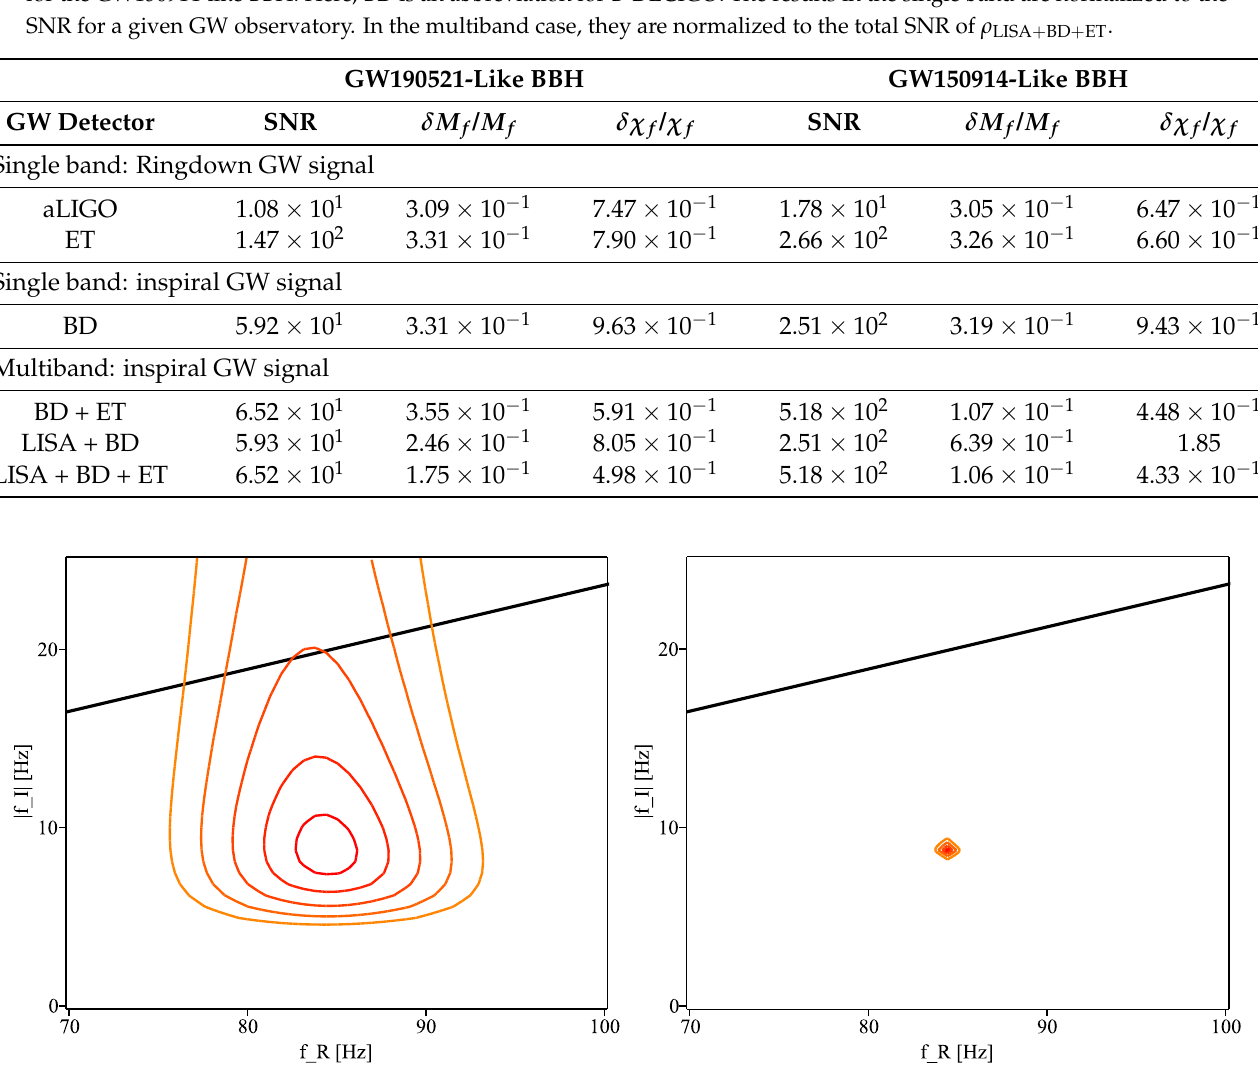
Figure 2. Simple remnant test in the ( f R , f I ) plane. The QNM frequency is given in the observer frame, and we assume the GW190521-like ringdown GW signals with ( M f / m , χ f ) ∼ ( 0.904,0.883 ) (27). The figure shows the parameter estimation error with the aLIGO noise curve (left, SNR = 1.08 × 10 1 ) and the ET one (right, SNR = 1.47 × 10 2 ). The black lines are the Schwarzschild limit of | f I | / f R ≈ 0.236. The colored ellipses show the contours of 1 σ , 2 σ , 3 σ , 4 σ , and 5 σ . To obtain these two-dimensional plots, the time and phase parameters ( t 0 , φ 0 ) have been marginalized